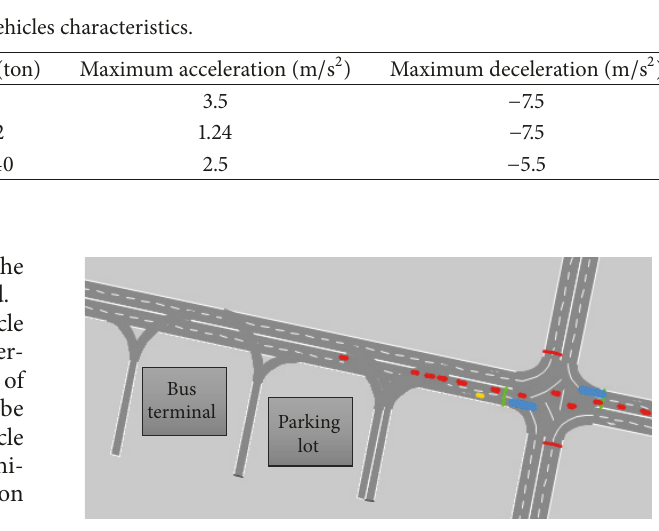
Figure 6: The status quo network modeled in